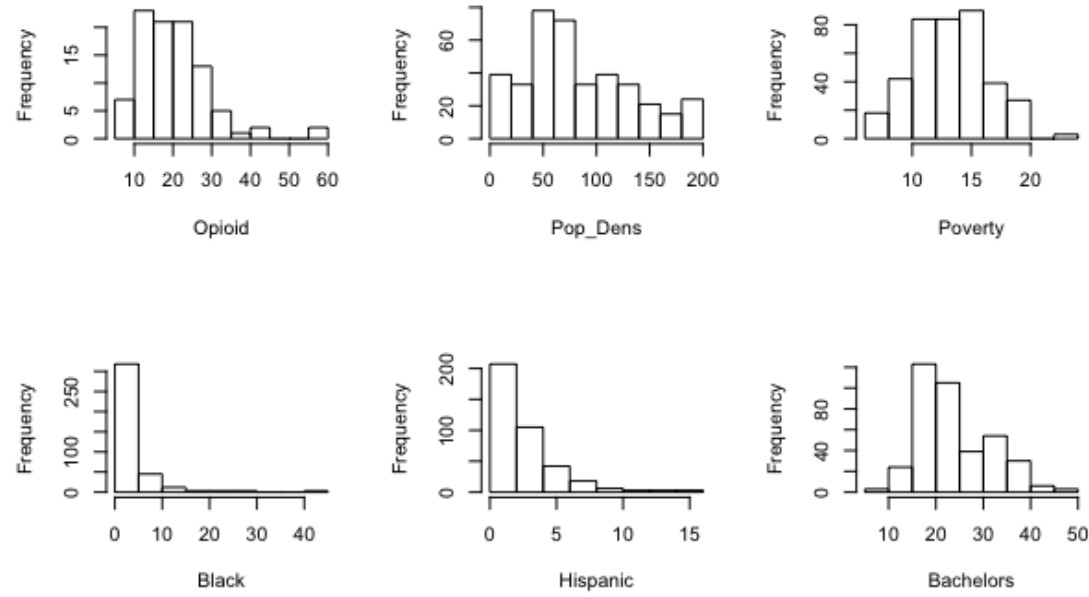
Figure A5. The distributions of rural county values of each of the numerical explanatory variables used in the model. Bachelors and poverty seem to demonstrate somewhat normal distribution, while Black and Hispanic demonstrate strong right skew.